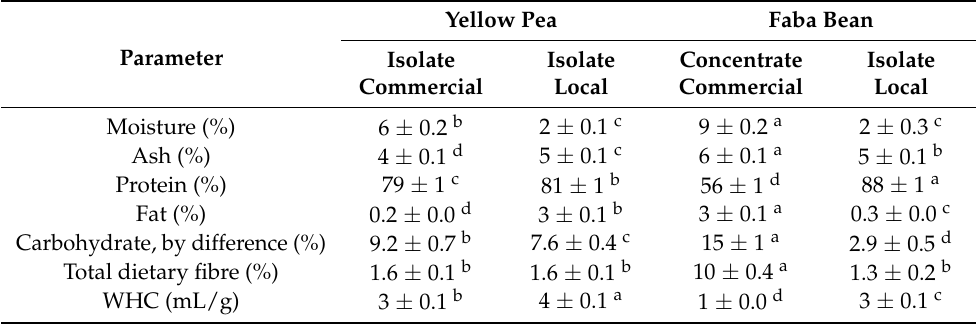
Table 1. Proximate composition (wet basis) and water-holding capacity (WHC) of commercial and local pulse protein isolates/concentrate 1 .